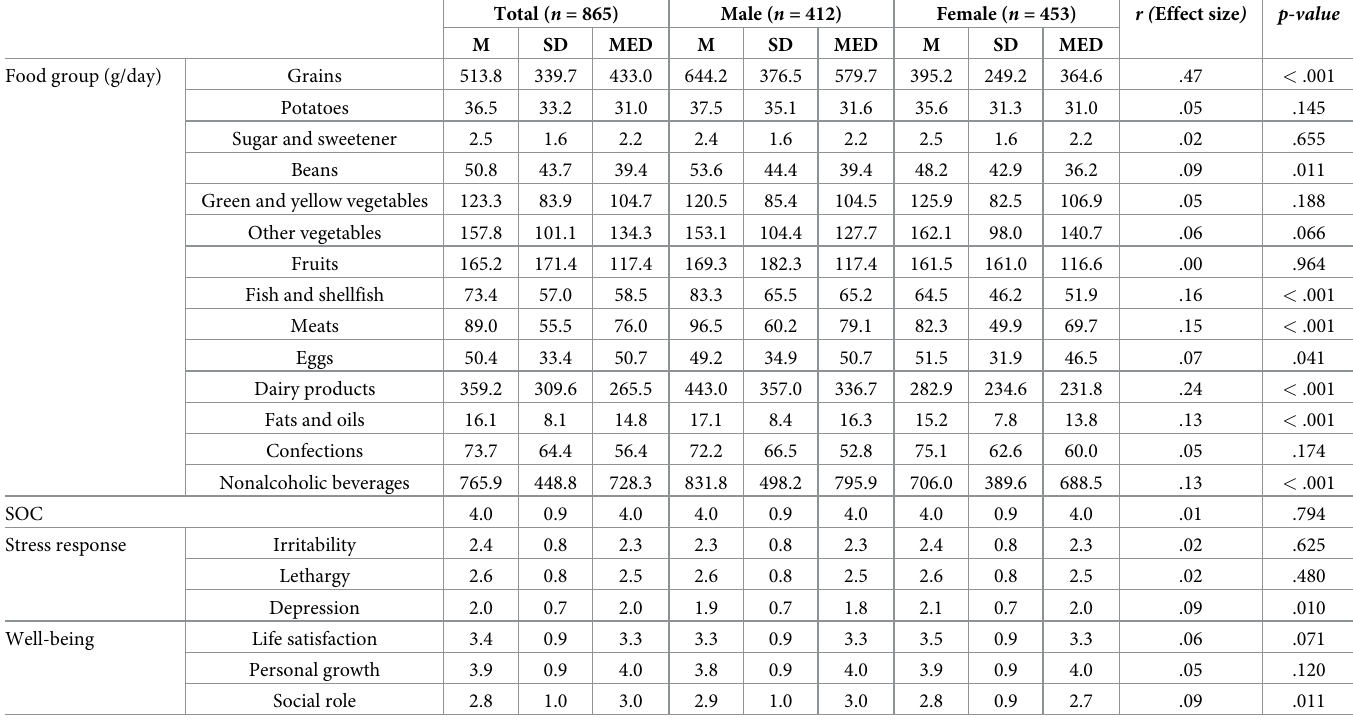
Table 2. Means, standard deviations, and medians for variables and the results of the Mann–Whitney U-test by sex. Total ( n = 865) Male ( n = 412) Food group (g/day) Grains